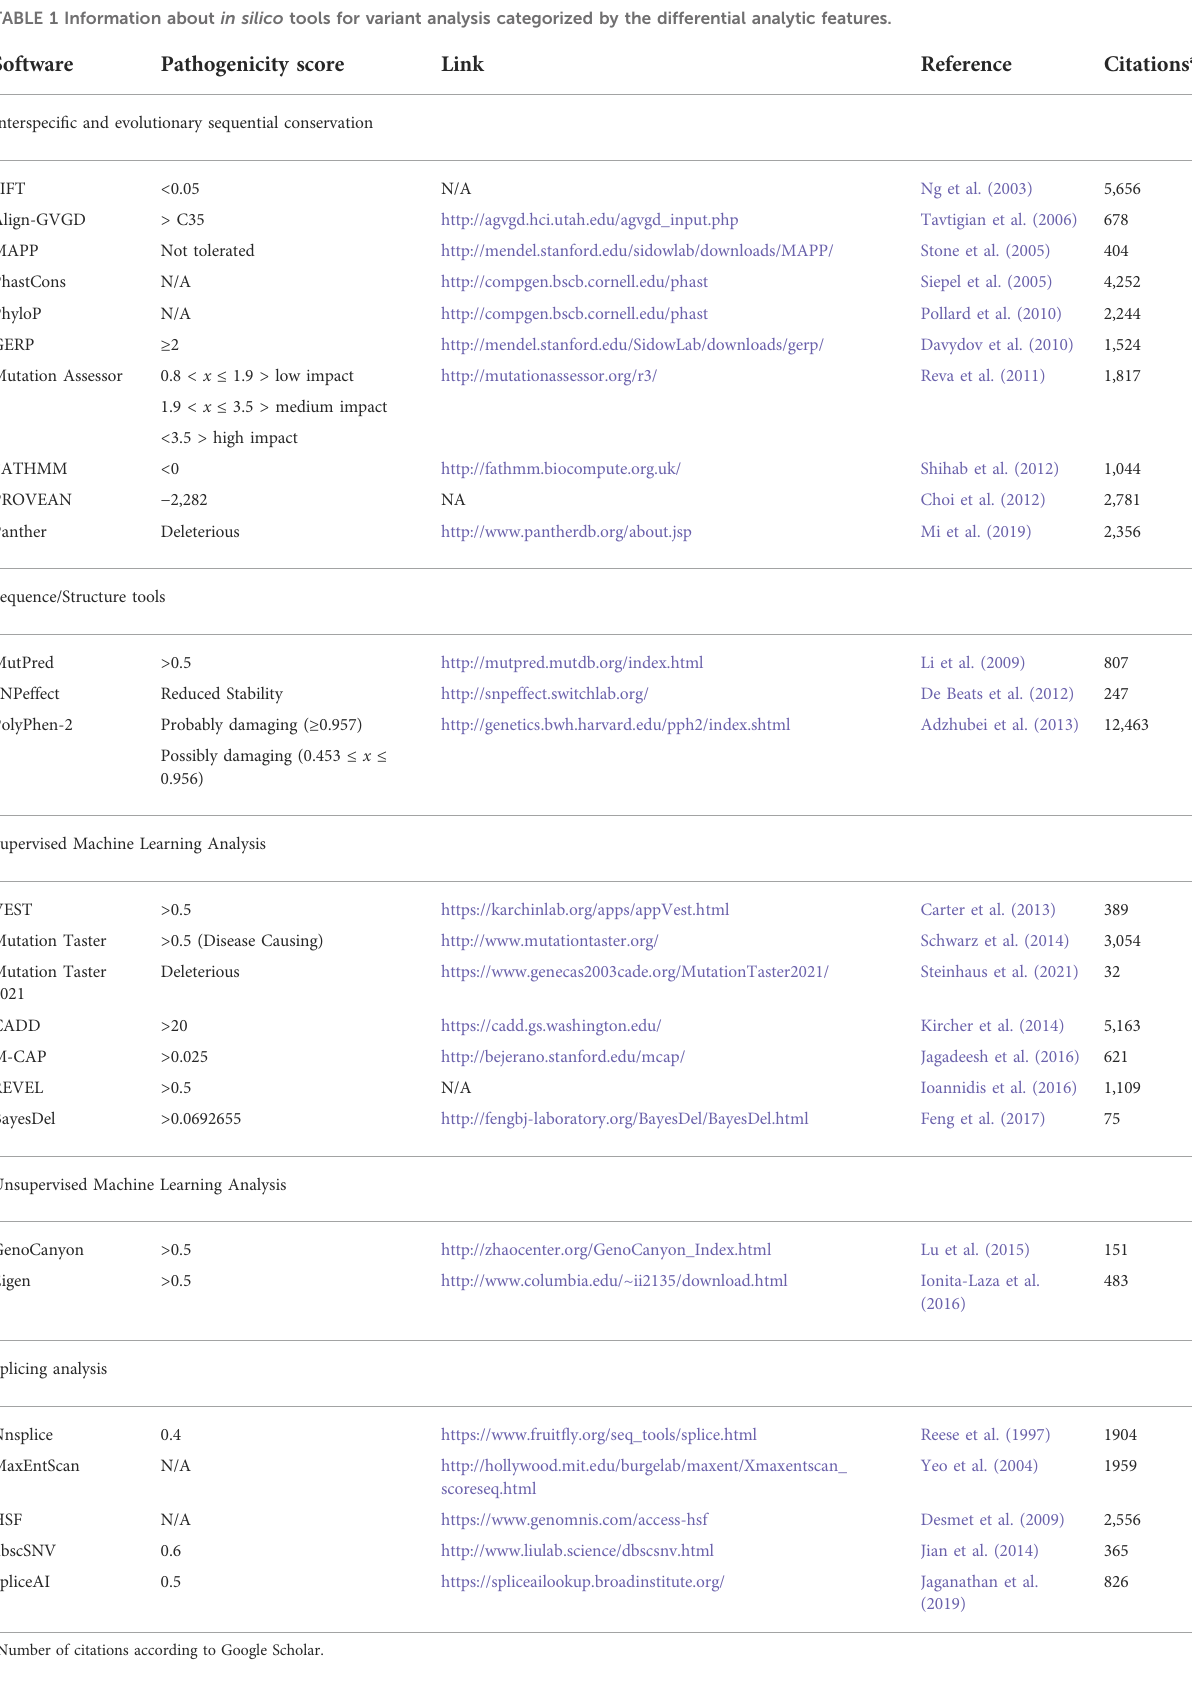
TABLE 1 Information about in silico tools for variant analysis categorized by the differential analytic